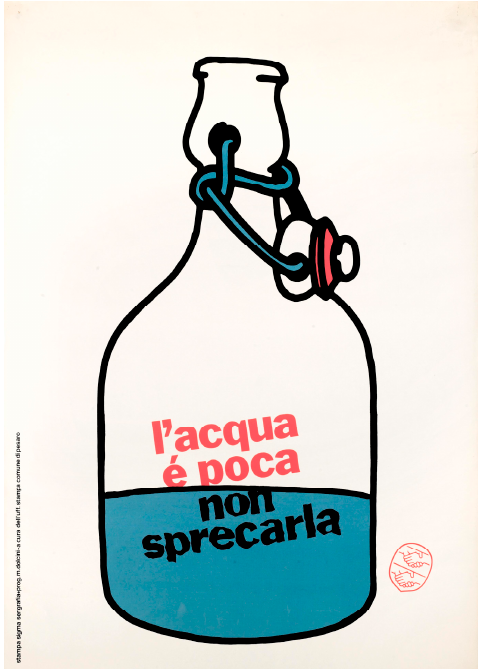
Figure 4. “l’acqua è poca non sprecarla”, Massimo Dolcini, ca. 1970.